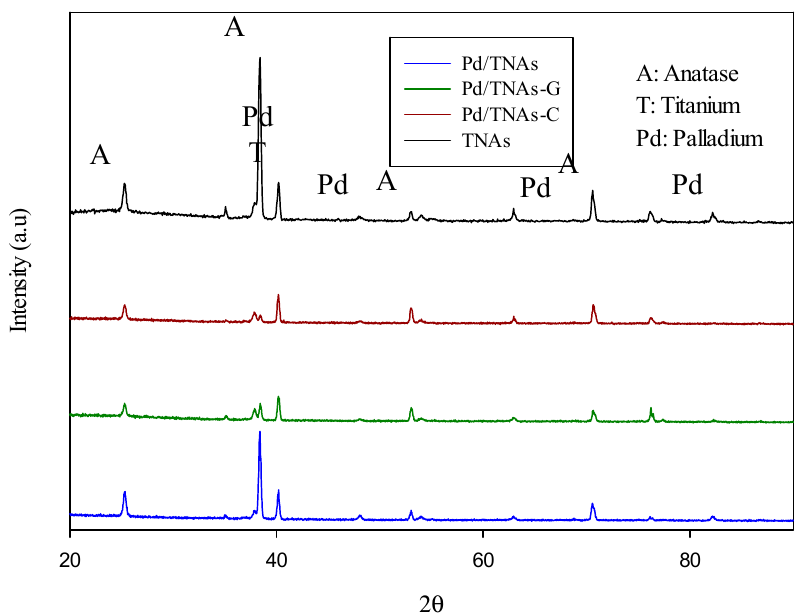
/ TNAs, Pd / TNAs-C, and Pd / TNAs-G. Figure 2. XRD analysis of TNAs, Pd/TNAs, Pd/TNAs-C, and Pd/TNAs-G. Figure 2. XRD analysis of TNAs, Pd